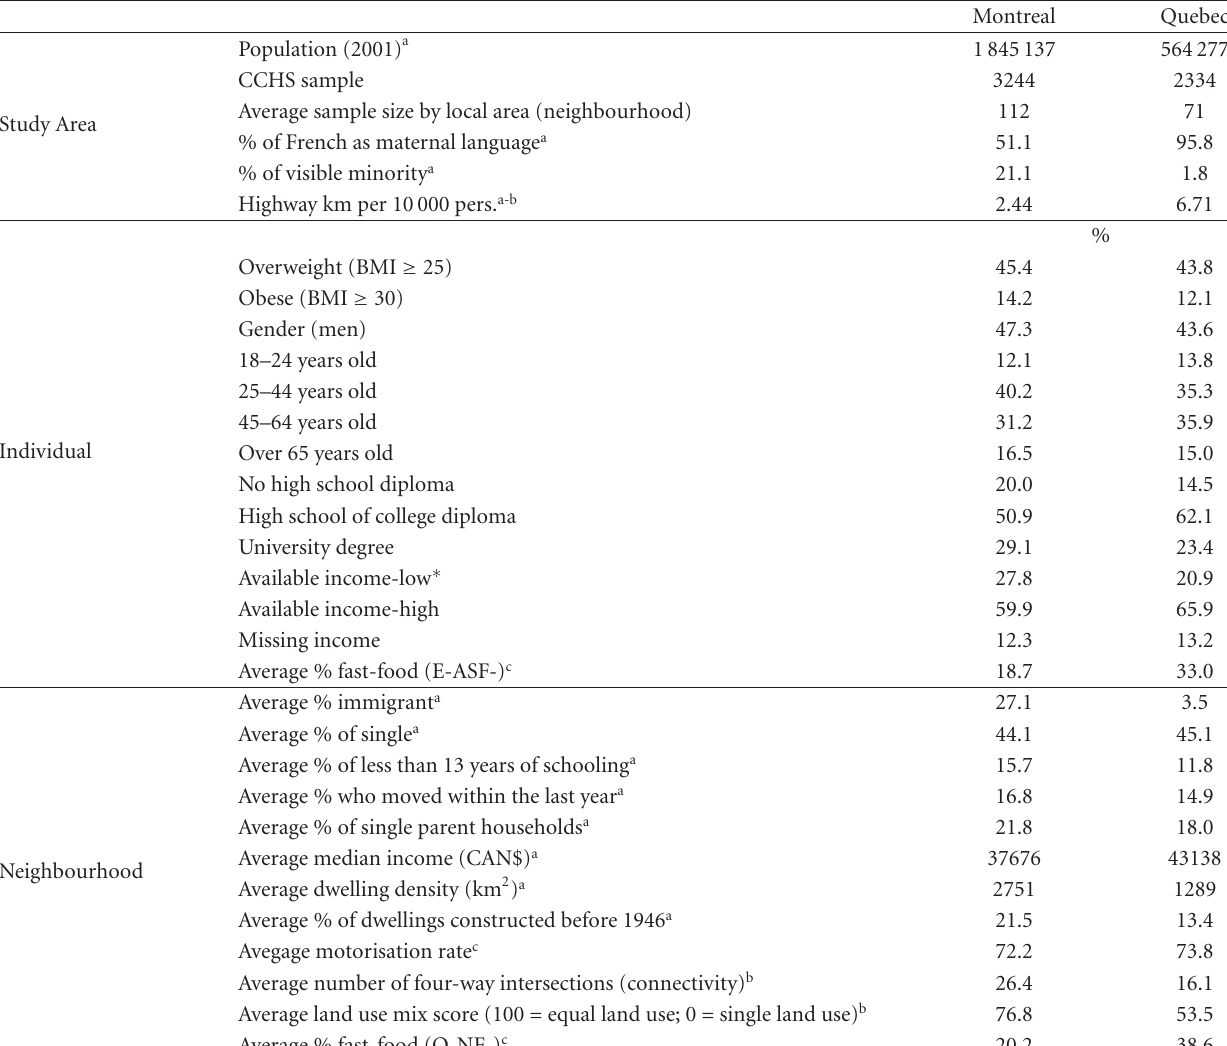
Table 1: Descriptive statistics for the Island of Montreal and Quebec City